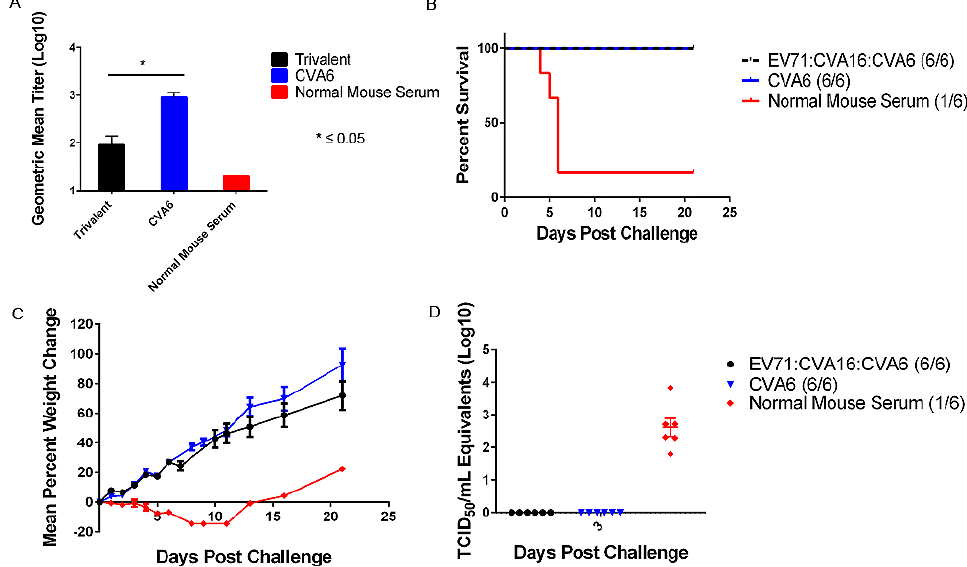
Figure 5. Monovalent CVA6 and trivalent antibodies provided protection against lethal challenge with mCVA6 in 3 week-old A129 mice. ( A ) Microneutralization assays were performed on serum collected 24 h post transfer to test for circulating antibody titers to CVA6. A significant difference was seen between the circulating titers in the group receiving monovalent CVA6 antibodies compared to the trivalent group; ( B ) The monovalent CVA6 and trivalent antibodies elicited complete protection against lethal challenge with mCVA6. A significant number of animals receiving normal mouse serum succumbed to infection; ( C ) Weight loss is a definitive clinical sign in mice challenged with mCVA6. Mice receiving normal mouse serum developed significant weight losses. The weight gain seen after day 11 post challenge in the normal mouse serum group is due to the one surviving mouse; ( D ) CVA6 viral loads were measured by real time RT-PCR. Significant viral loads were detected on day 3 in the normal mouse serum group. No detectable viral loads were detected in the CVA6 and trivalent groups.